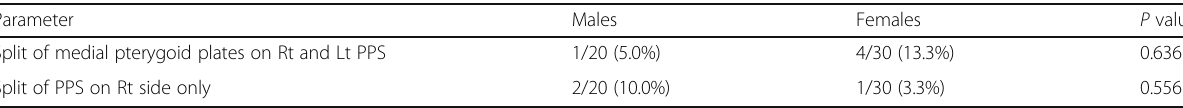
Table 4 Frequency of partial split of pterygopalatine suture (PPS) between males and females Parameter Males Females P value Split of medial pterygoid plates on Rt and Lt PPS 1/20 (5.0%) 4/30 (13.3%) 0.636 Split of PPS on Rt side only 2/20 (10.0%) 1/30 (3.3%)